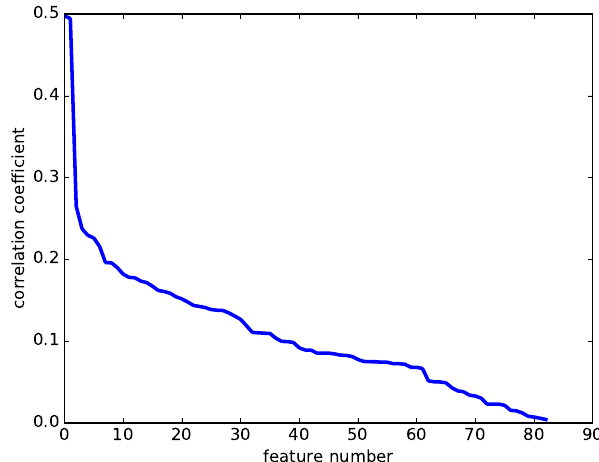
Figure 5. The variation of the correlation coefficients for the total VE scoring performed by the clinicians.